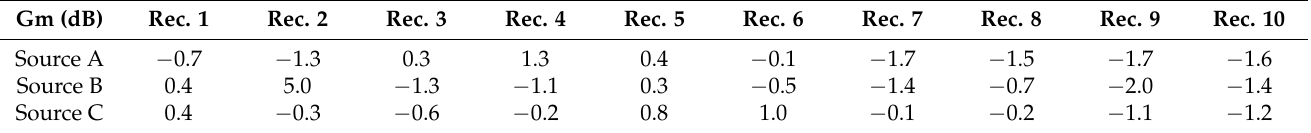
Table 4. Gm values of each source–receiver pair in the